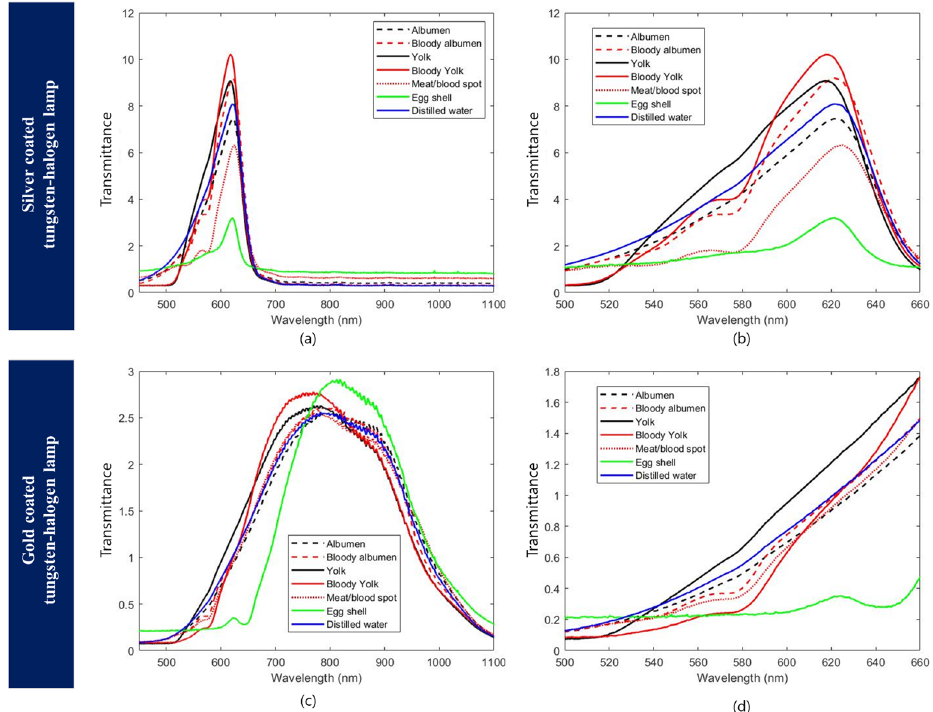
Figure 6. Comparison of gold and silver light patterns for normal and abnormal egg elements: ( a , b ) The spectrum for each element of abnormal and normal eggs obtained through a silver-coated halogen-tungsten lamp; ( c , d ) The spectrum for each element of abnormal and normal eggs obtained through a gold-coated halogen-tungsten lamp.